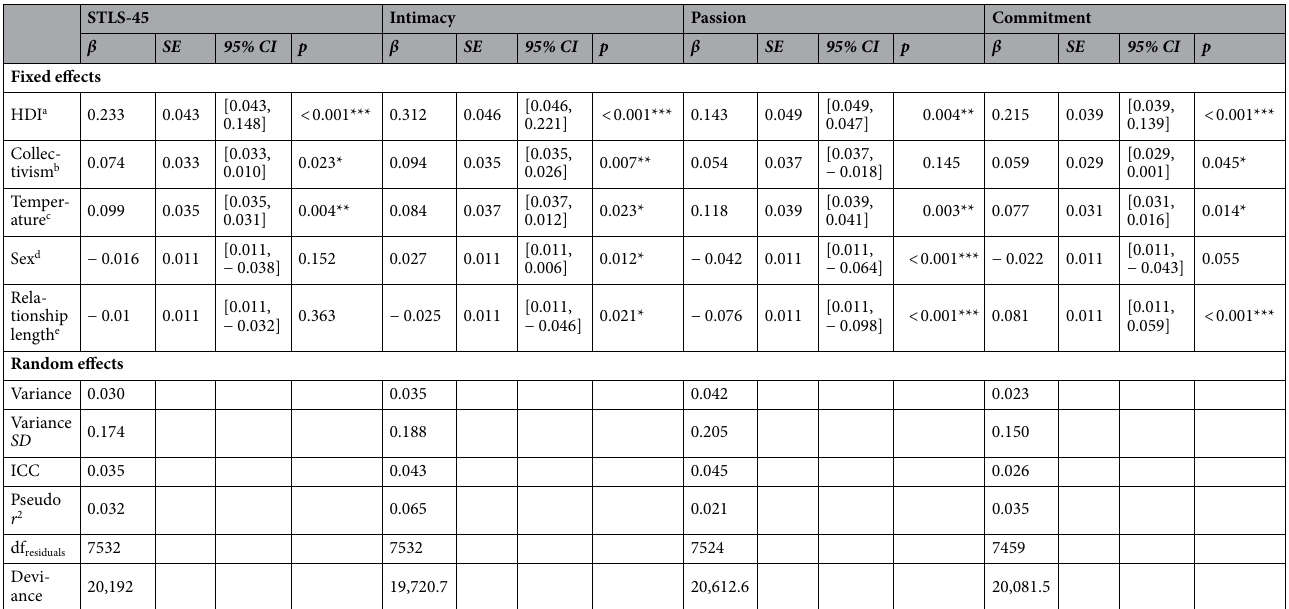
Table 1. Results of the multilevel linear models regressing love components (i.e., STLS-45, intimacy, passion, and commitment) on countries’ levels of Human Development Index (HDI), Collectivism level, annual average temperature, and participants’ sex and length of relationship (in months), with participants nested within countries. *p < 0.05, **p < 0.01, ***p < 0.001. a Human Development Index, b Collectivism-in-group